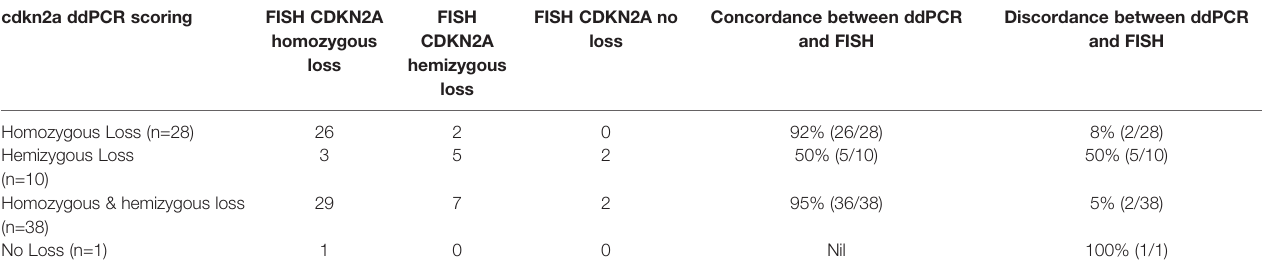
TABLE 8B | Comparison of droplet digital PCR (ddPCR) and fl uorescence in situ hybridization (FISH) results for detecting CDKN2A homozygous and hemizygous